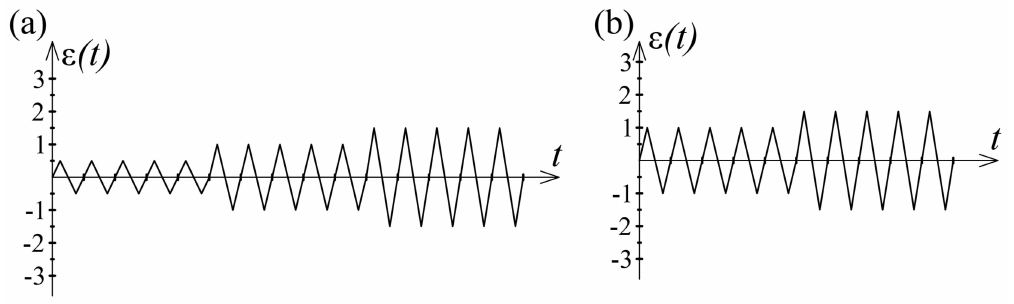
Figure 15. ( a ) Load history A; ( b ) Load history B.